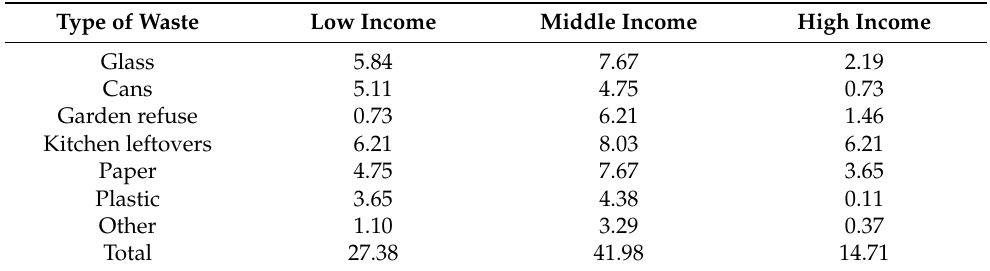
Table 4. The illustration of solid waste generated in tonnes by different income levels in Maseru in 2011. Type of Waste Low Income Middle Income High Income